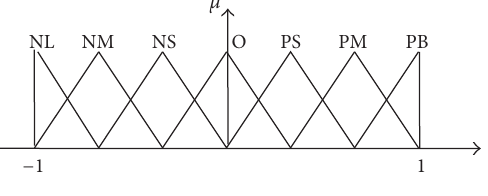
Figure 13: Fuzzy sets for 𝑒 𝑖 , Δ𝑒 𝑖 , and Δ𝑢